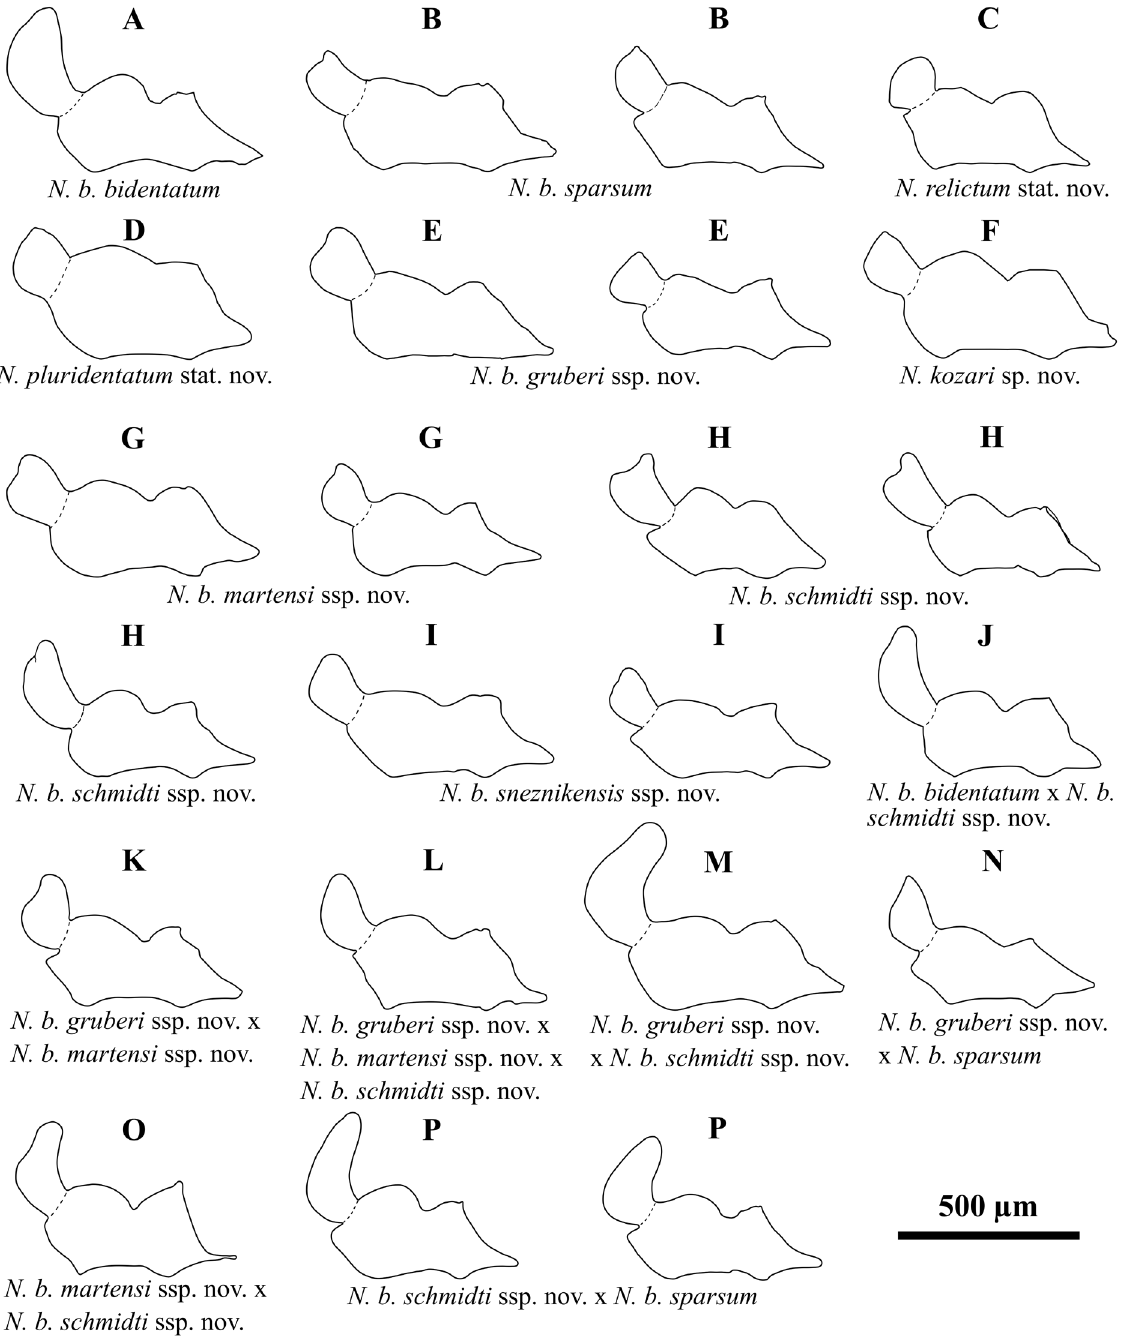
Fig. 9. Nemastoma bidentatum Roewer, 1914 complex, ♂♂. Variation of the Ch basal article (medial view) in species, subspecies and